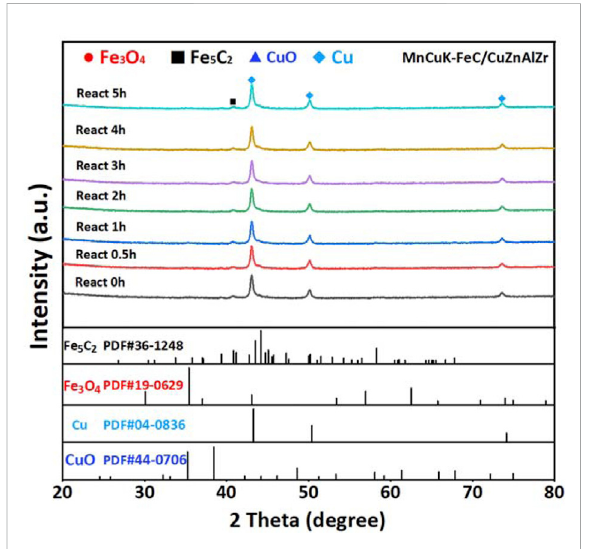
FIGURE 7 In-situ XRD patterns during reaction process of the MnCuK- FeC/CuZnAlZr catalyst. (1:1 powder mixing and fi lling).